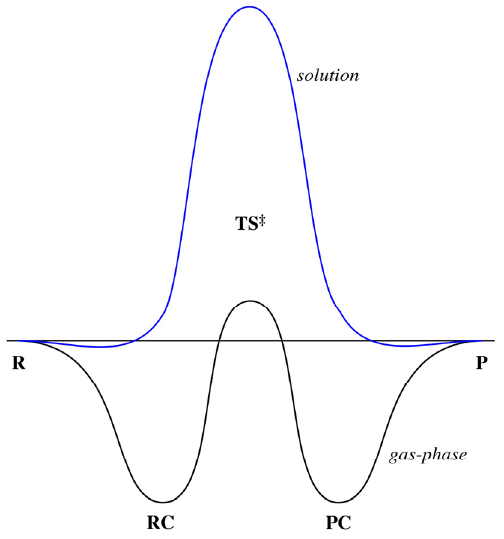
2 reaction in gas phase and in N